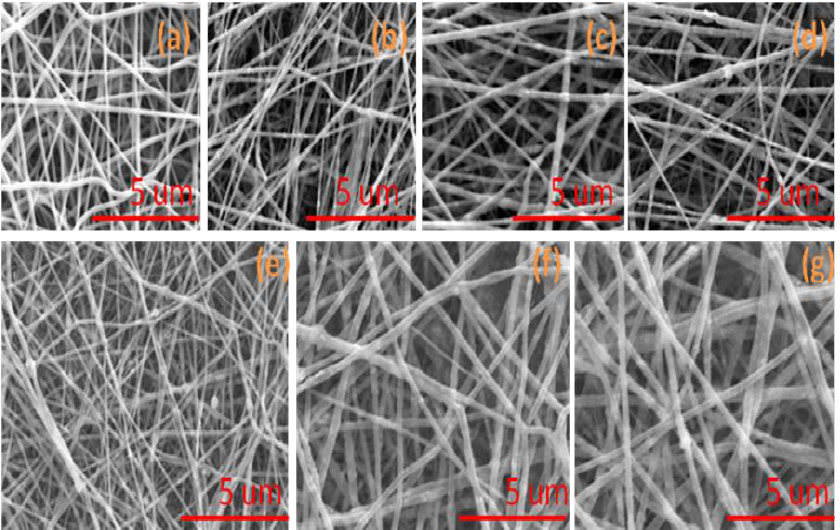
Figure 2. Scanning electron microscope (SEM) images of ( a ) Neat PVA nanofibers; ( b ) 5% PVA/ZnO nanofibers; ( c ) 7% PVA/ZnO nanofibers; ( d ) 9% PVA/ZnO nanofibers; ( e ) 5% PVA/TiO 2 nanofibers; ( f ) 7% PVA/TiO 2 nanofibers; ( g ) 9% PVA/TiO 2 nanofibers.